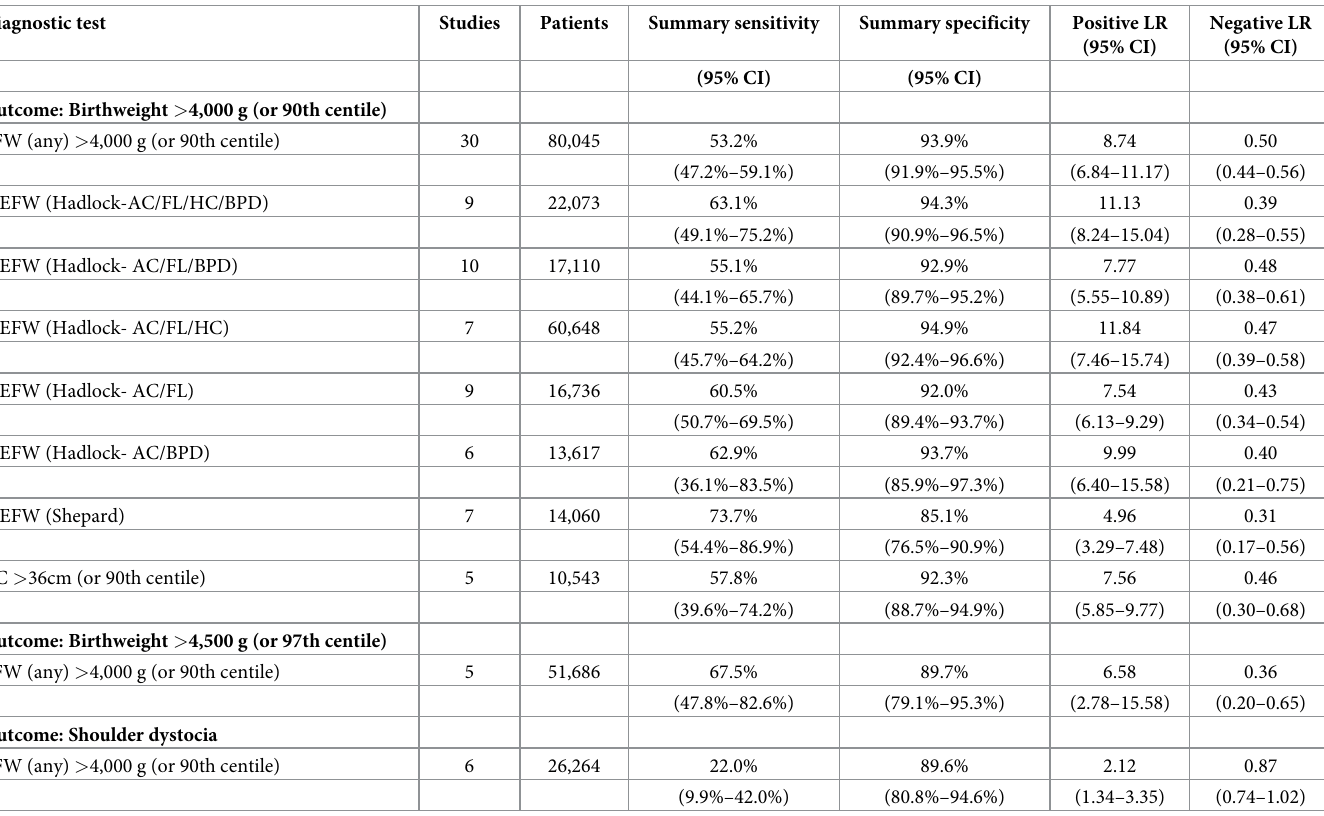
Table 1. Summary diagnostic performance of suspected LGA to predict adverse perinatal